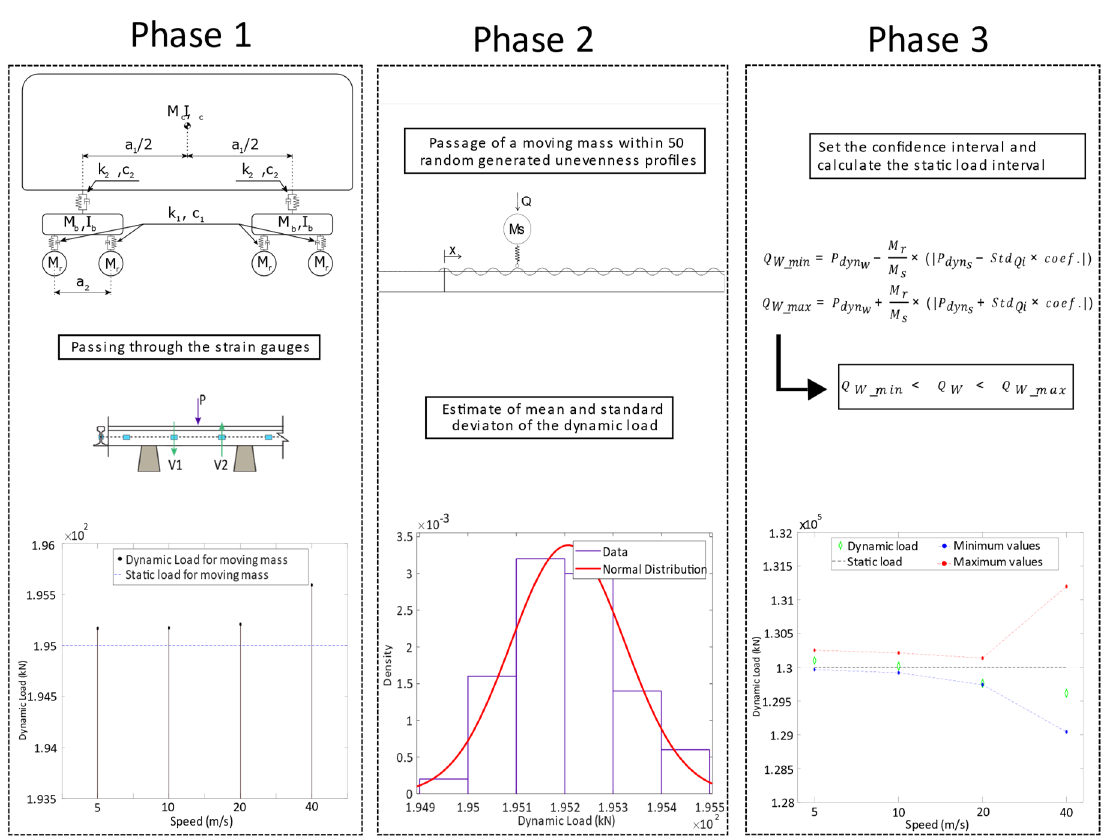
Figure 9. Schematic representation of the proposed WIM methodology.